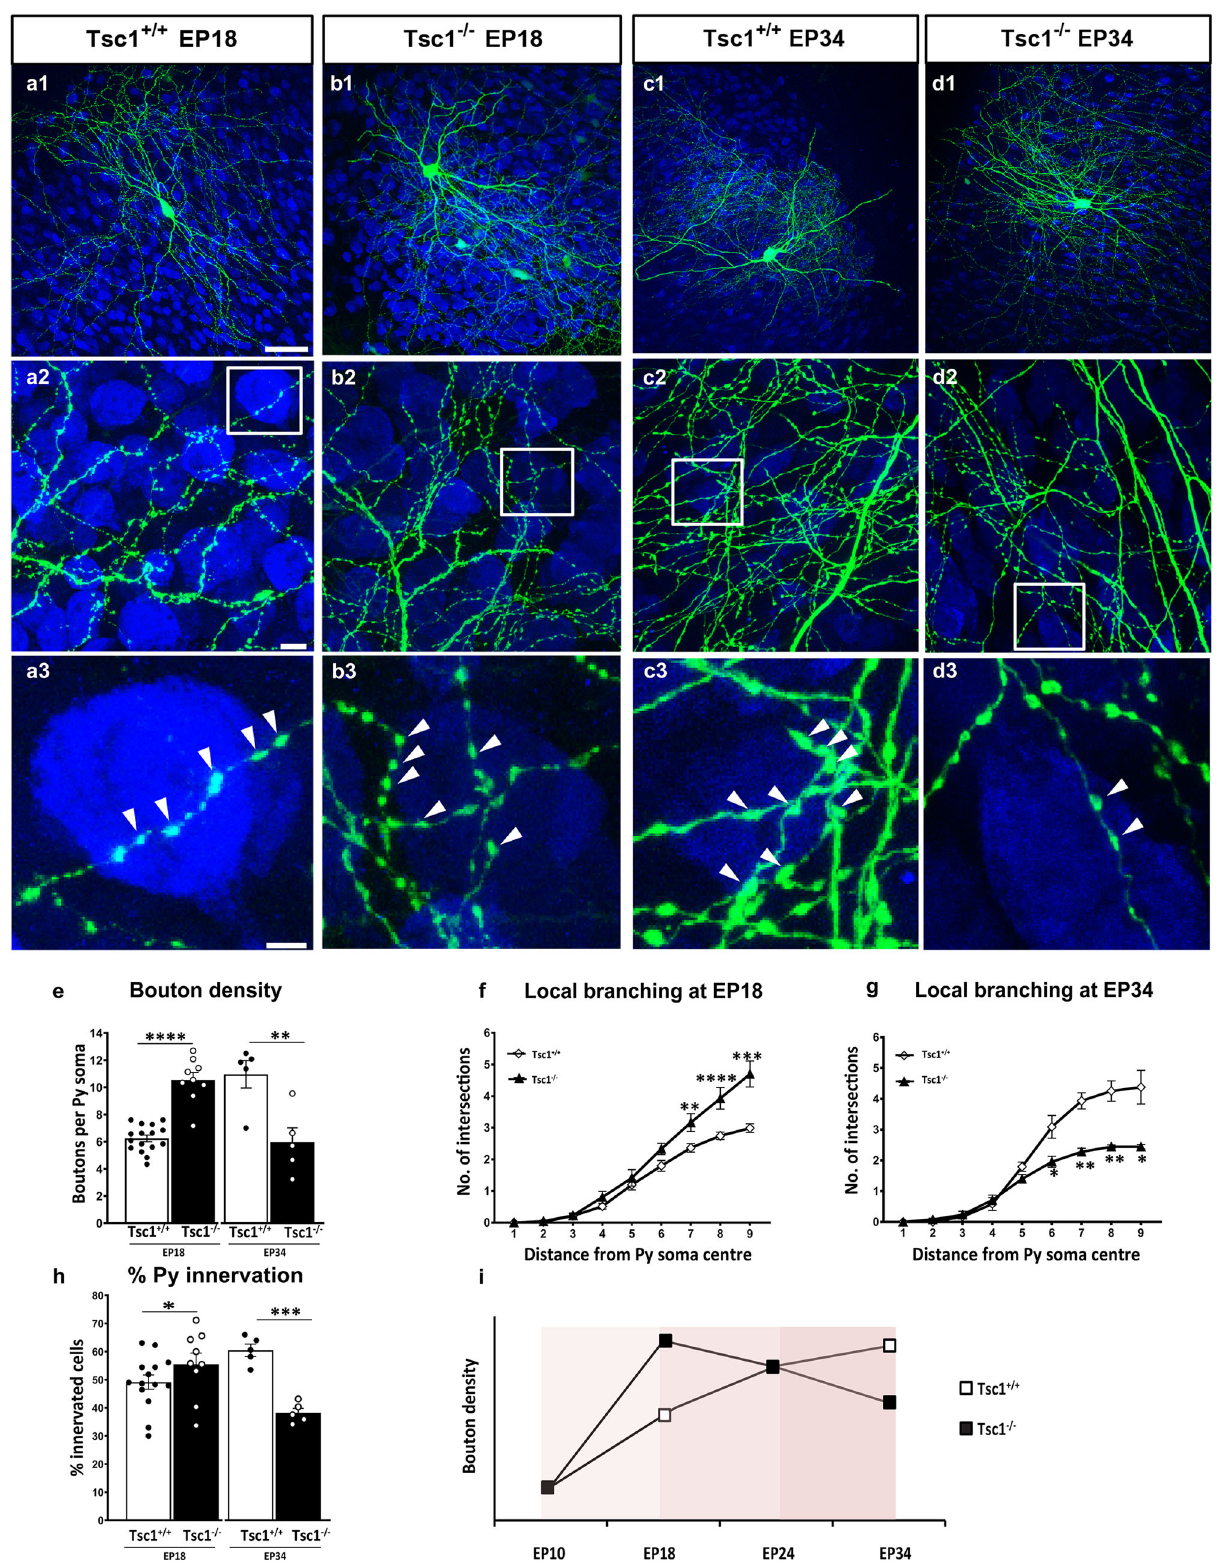
expression levels of the autophagosomal lipidated microtubule- associated protein 1 light chain 2 (LC3-II), of the autophagy substrate p62/sequestosome 1 and of the autophagy-initiating kinase Unc-51-like-kinase (ULK1) in Tg( Nkx2.1Cre ); Tsc1 fl ox/ fl ox mice compared to that of their control littermates in young and